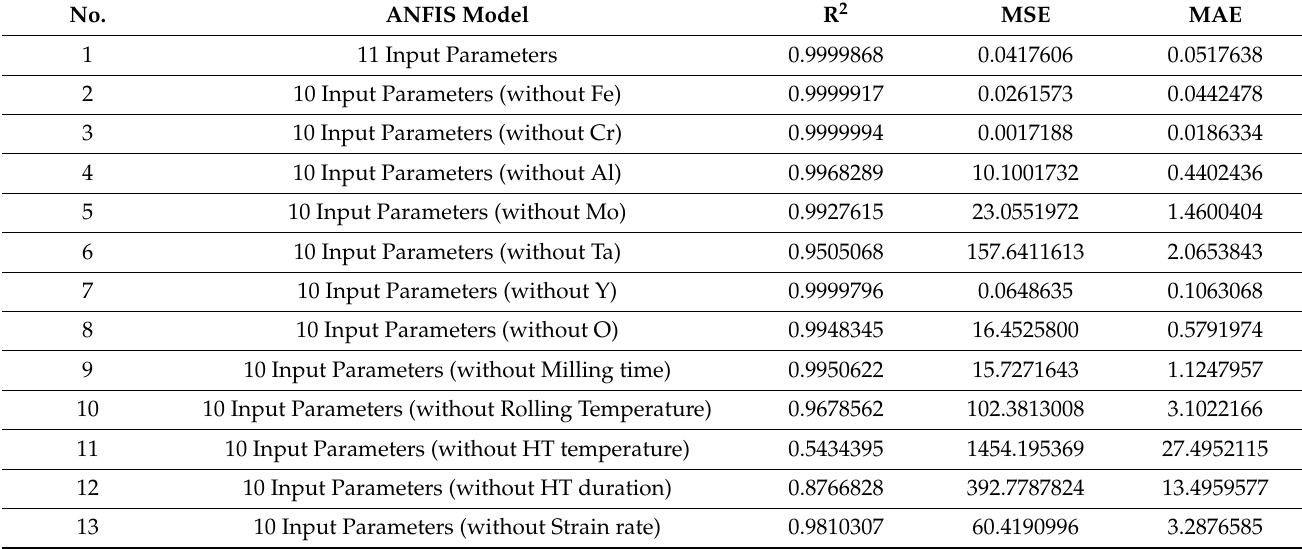
Table 6. The R 2 , MSE, and MAE values for the SA of the ANFIS model.